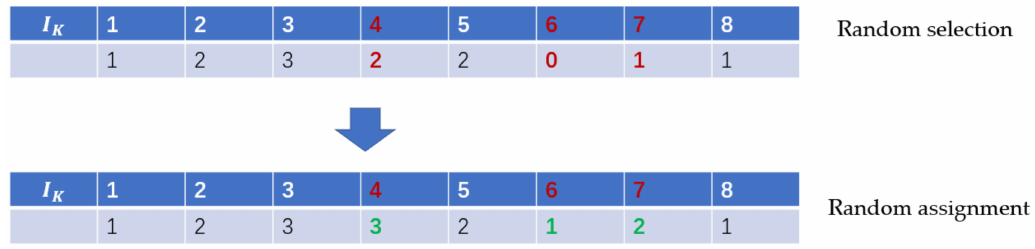
Figure 4. The siege strategy using random assignment.